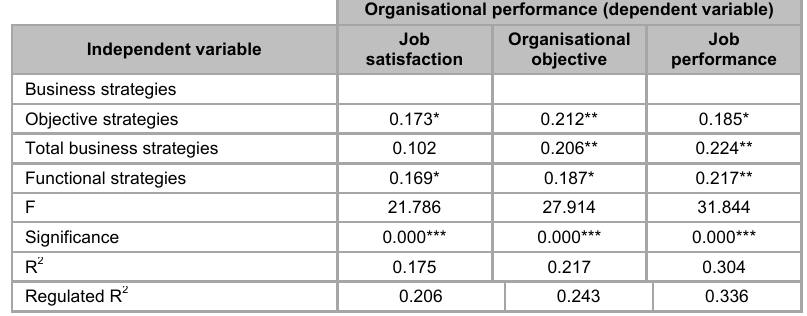
Multiple regression analysis of business strategies and job performance in organisational